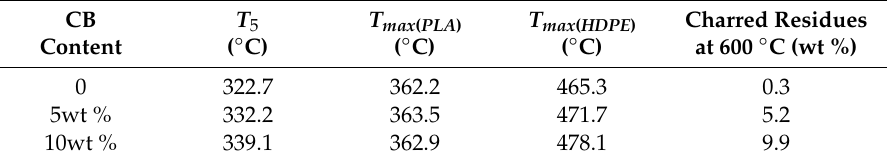
Figure 6. ( a ) TGA and ( b ) DTG curves of PLA70/30HDPE/CB with different CB loadings. Table 3. The thermal parameters of PLA70/30HDPE/CB with different CB loadings from thermogravimetric analysis (TGA).